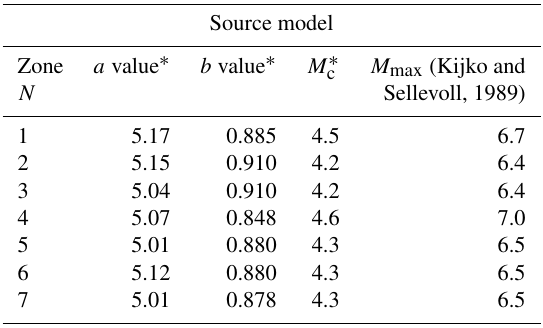
Figure 3. New seismic source zones identified for Patna based on seismicity parameters (variation in b value is shown in background). Table 4. Seismic parameters for adopted source models (uncertain- ties with